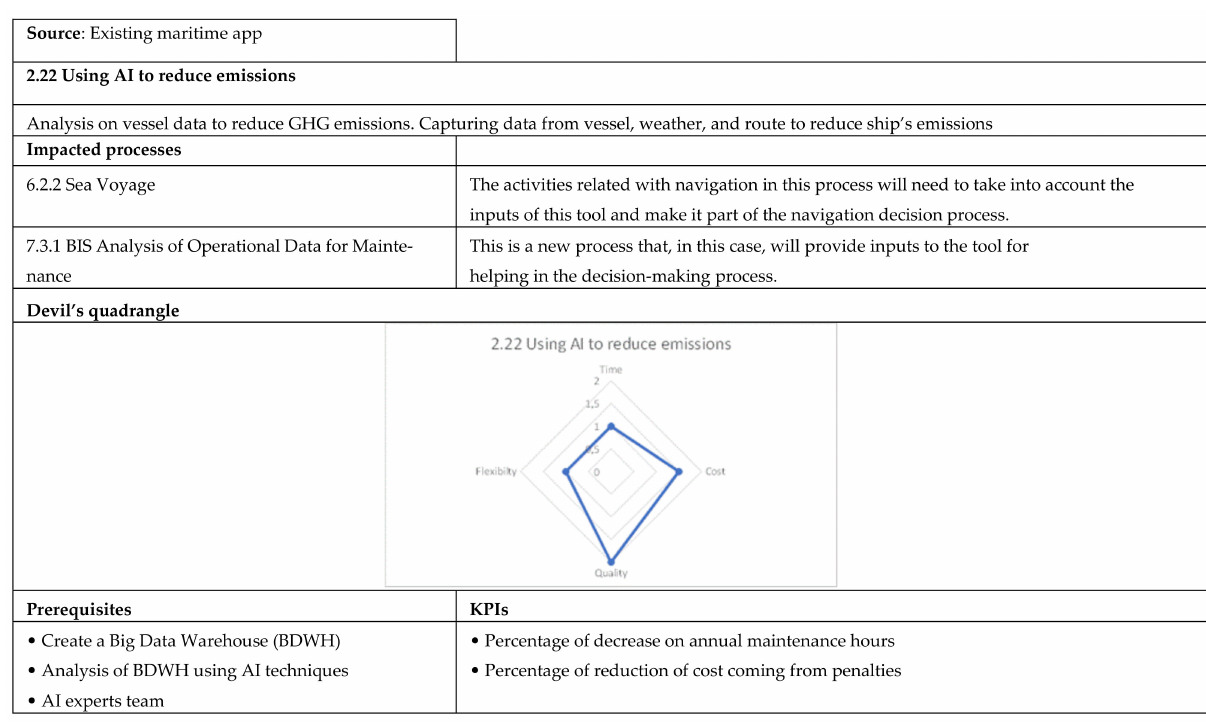
Figure A26. Using AI to reduce emissions data sheet.